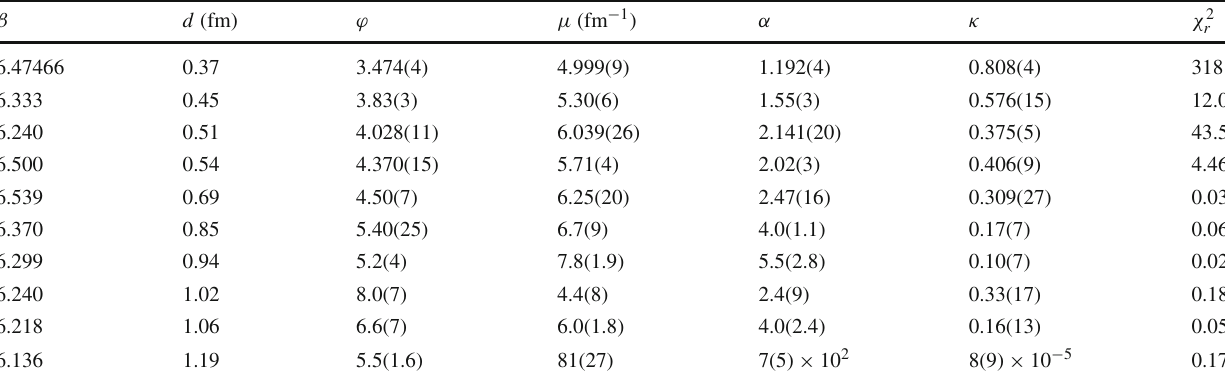
Table 3 The Clem parameters describing the non-perturbative field transverse section going through the midpoint between the quark and antiquark positions. The data for the fit is obtained using the curl subtraction procedure, taking the perturbative field at y max + 1 equal to zero β